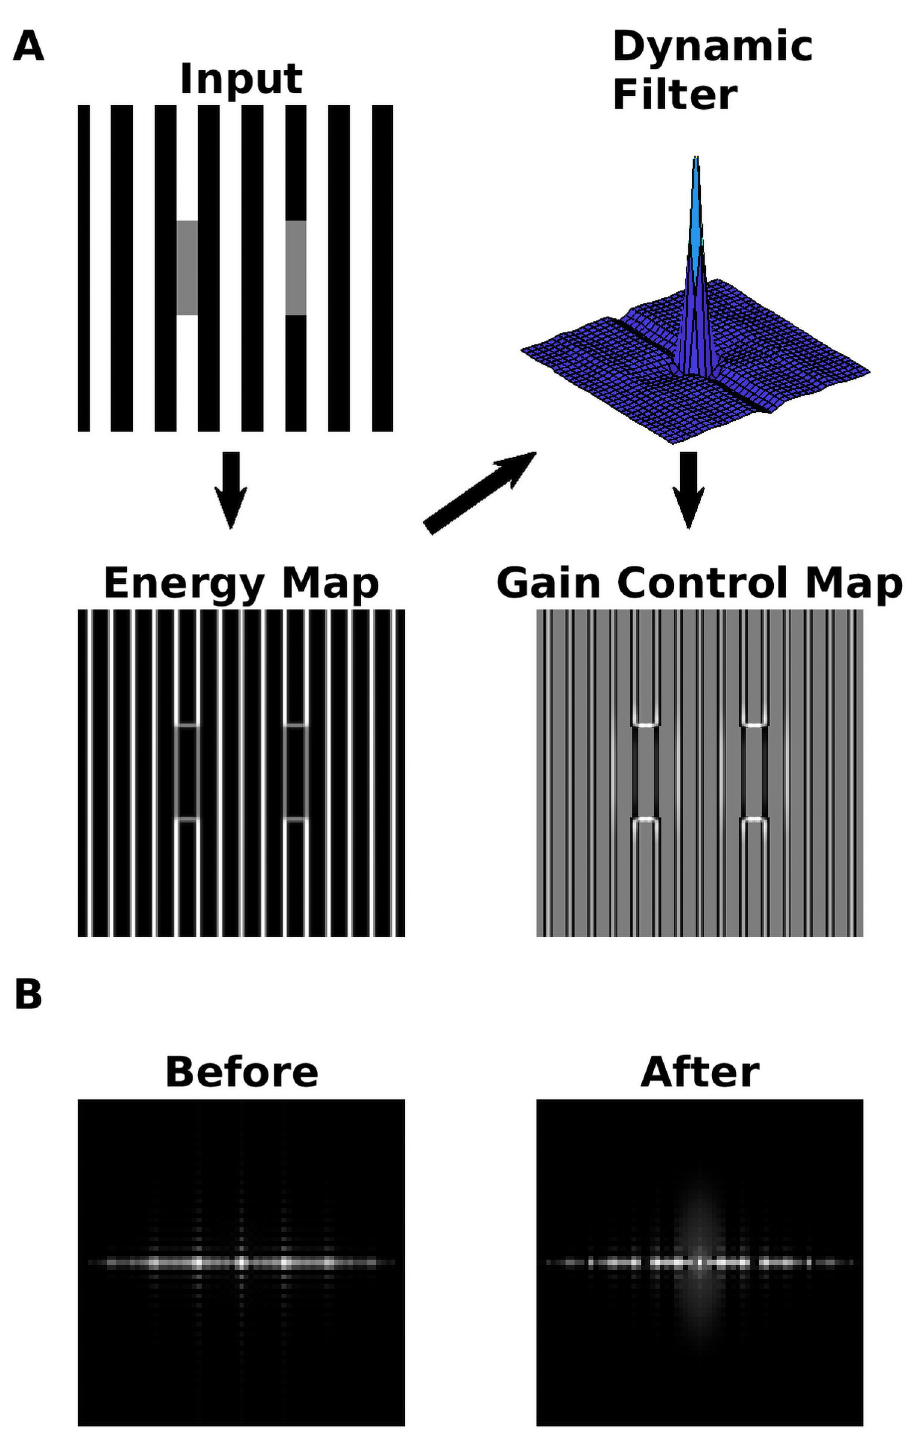
Fig 4. Action of the dynamic filter. (A) The arrows indicate the steps in order to obtain the gain control map: (i) A local energy map is computed; (ii) a dynamical filter is constructed with a customized zero-phase whitening procedure (ZCA, see section C in S1 Text); (iii) a gain control map is obtained by filtering the energy map with the dynamical filter (see subsection Gain Control Map). (B) The power spectrum (= square of amplitude spectrum) before and after of applying the dynamic filter on the local energy